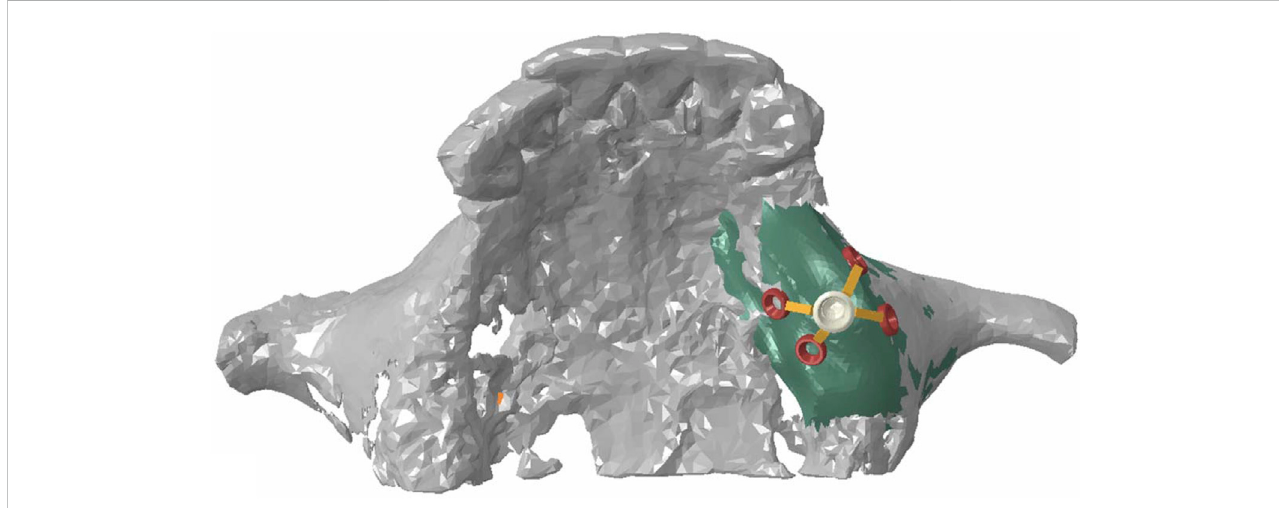
FIGURE 2 Assembly diagram of maxillary model and Yang ’ s implant model.